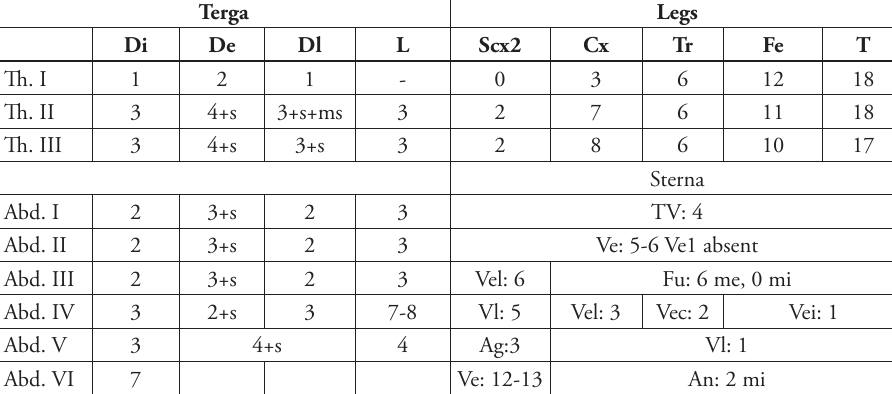
Table 3c. Chaetotaxy of Yuukianura deharvengi sp. n.: postcephalic chaetotaxy.